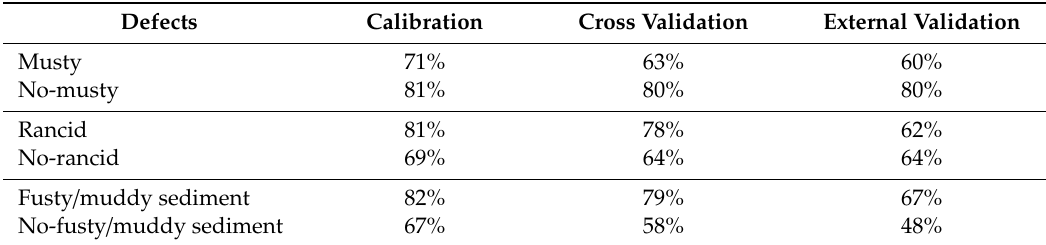
Table 3. Percentages of correctly classified samples by the 3 PLS–DA models to determine the presence of defects in virgin olive oils (musty vs. no-musty; rancid vs. no-rancid; fusty / muddy sediment vs. no-fusty / muddy